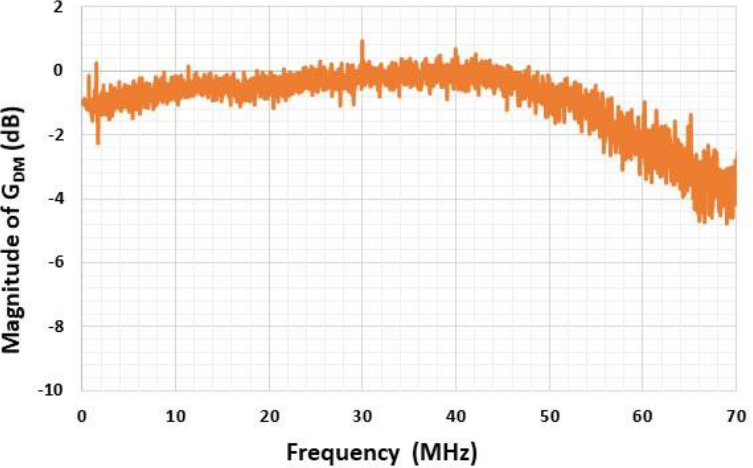
Figure 22. Measured magnitude of the differential gain of the conditioning circuit versus frequency.